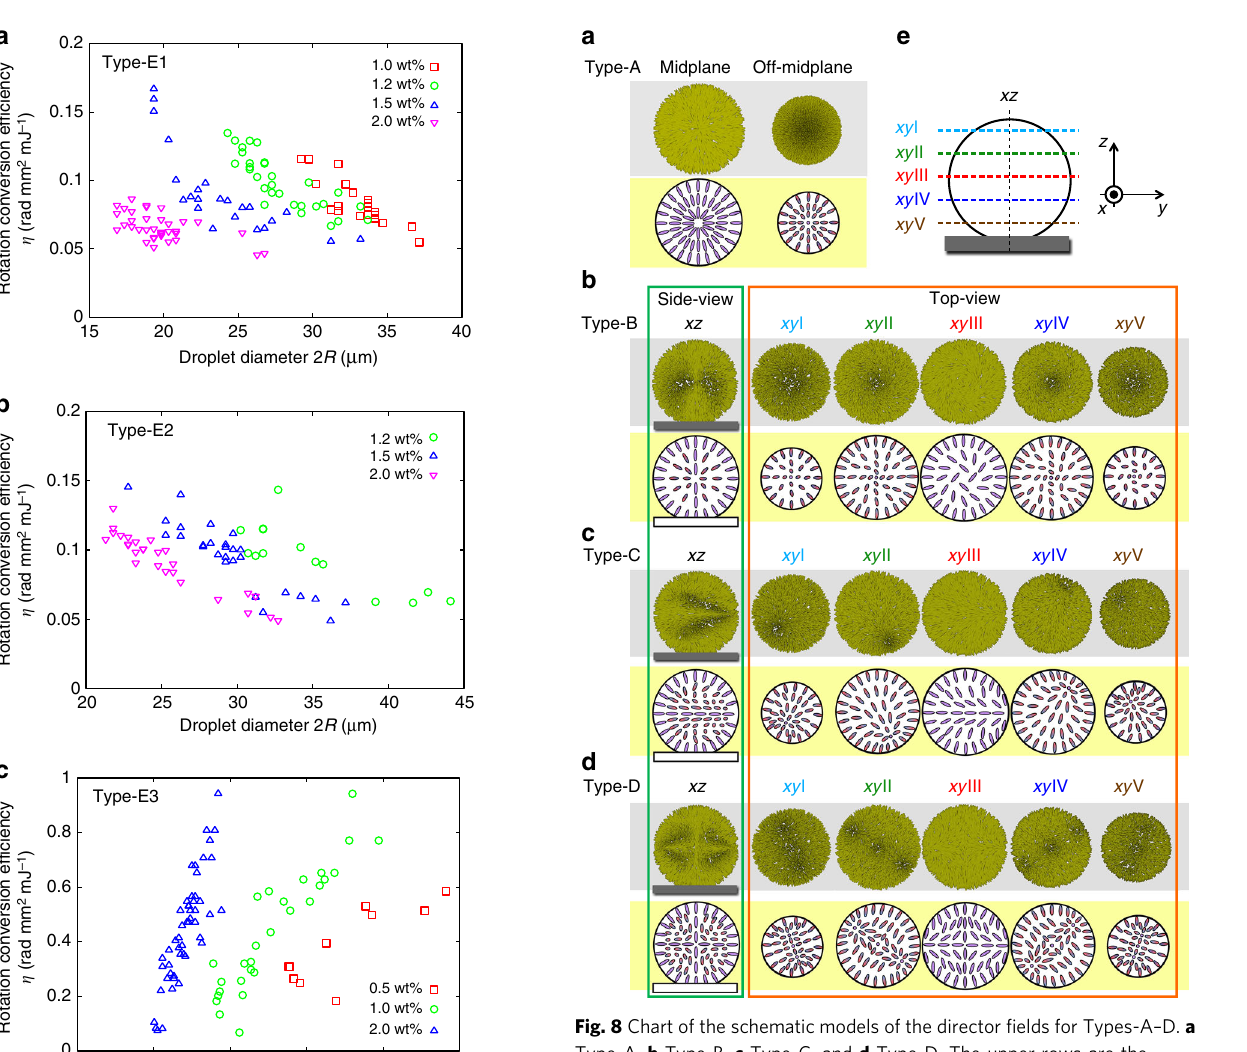
Type-D with a double helix having three point defects . Type-D appears in almost the same range of N as Type-C, and a similar state has also been reported in the literature 22,23 . The cross- sectional CFM images of the Type-D droplet upon HIR are shown in Supplementary Fig. 3. Figures 1r and 8d are the structural model for the director fi eld based on this observation.